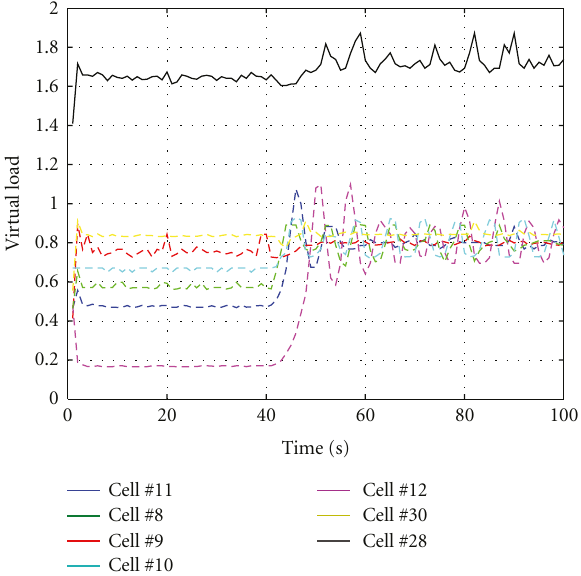
Figure 8: Virtual load in overloaded cells no.11 and neighbors. Figure 9: P0 settings in overloaded cell no.11 and neighbors.